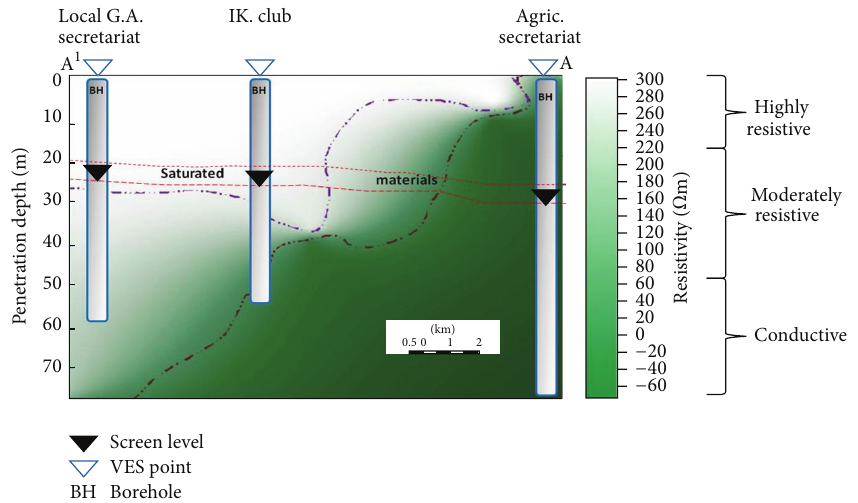
Figure 5: Resistivity cross section along a profile from Agric. secretariat to Local G. Area Secretariat (A-A 1 ).